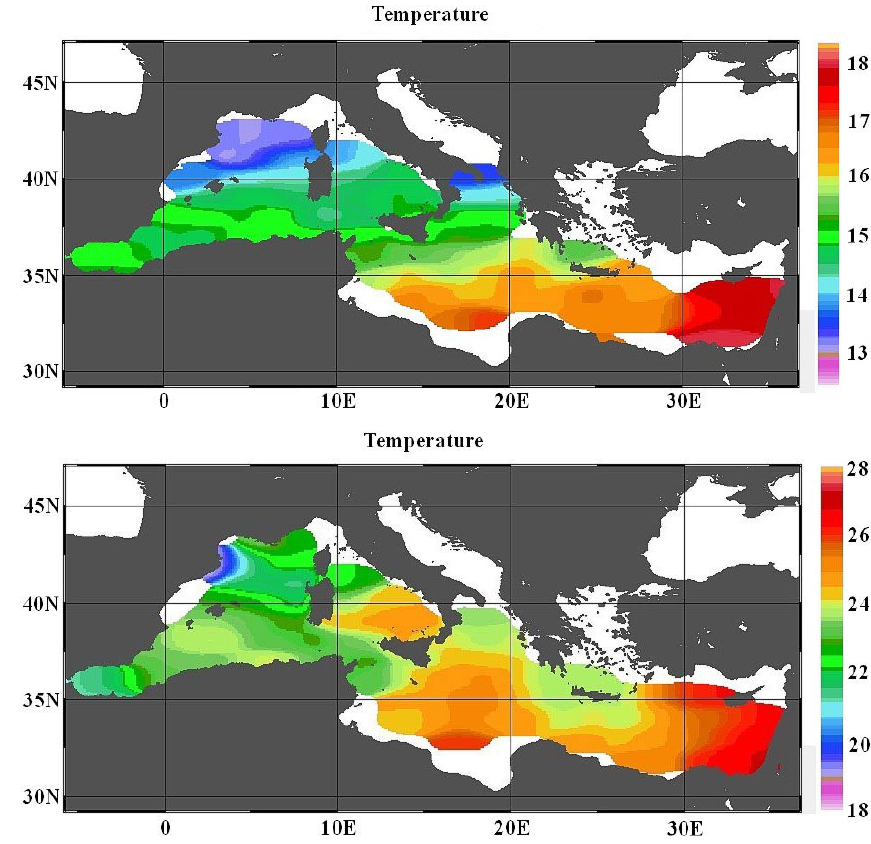
Fig. 6. Climatological temperature fields at surface in January (a) and July (b) . Temperatures at 5m